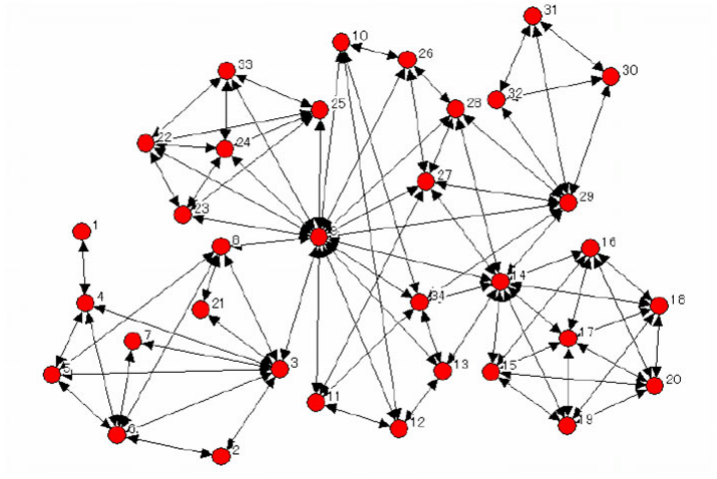
Figure 2. Personal